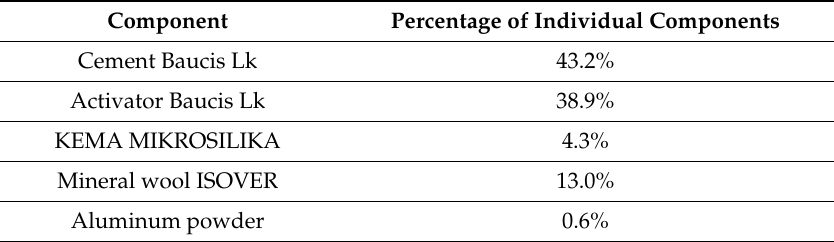
Table 1. Geopolymer